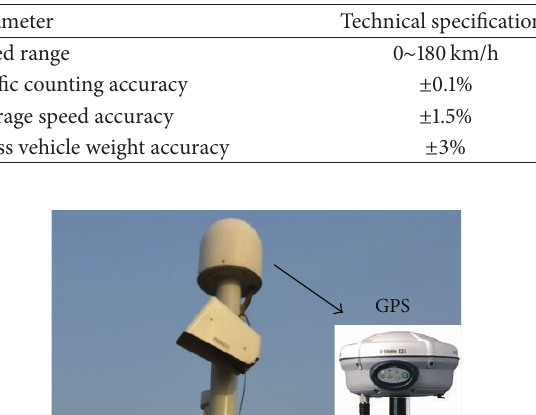
Table 3: Weigh-in-Motion system technical specifications.